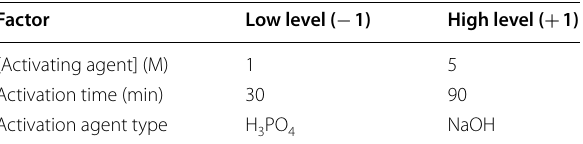
Table 1 Levels of factors applied for the preparation of DGP active carbon